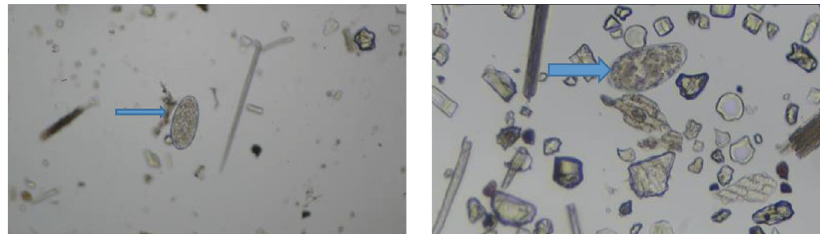
Figure 6: Fasciolopsis spp. (blue